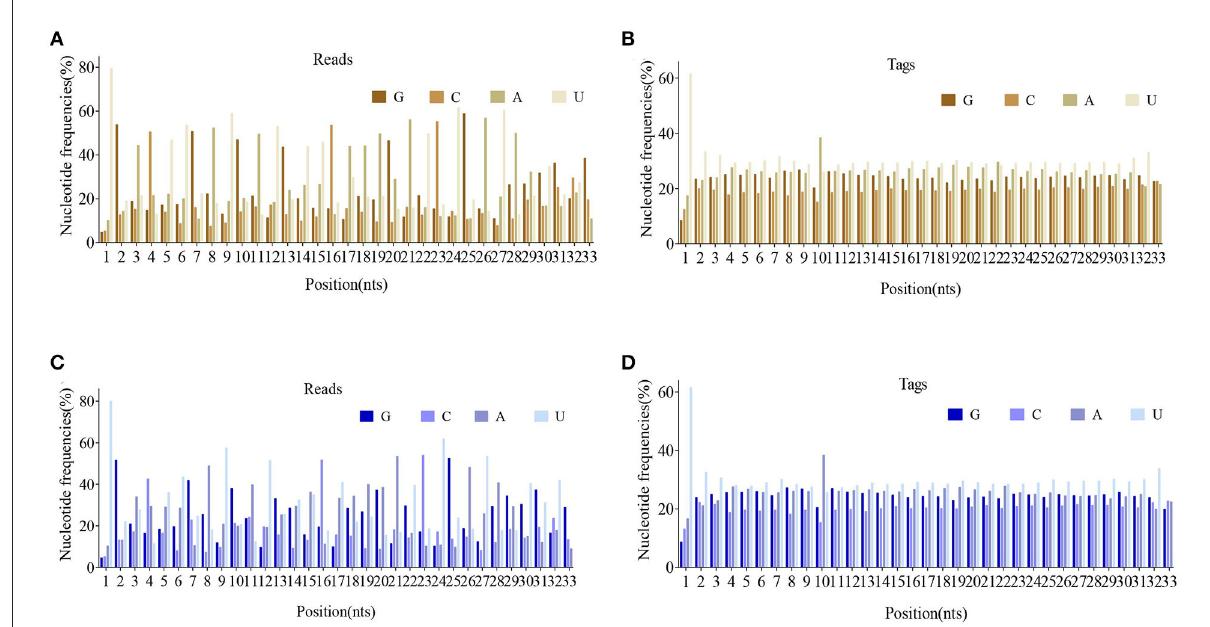
FIGURE2 5 ′ -3 ′ positional nucleotide frequencies of piRNAs in two groups. piRNA base bias (A) and the unique base bias (B) in FP. piRNA base bias (C) and the unique base bias (D) in